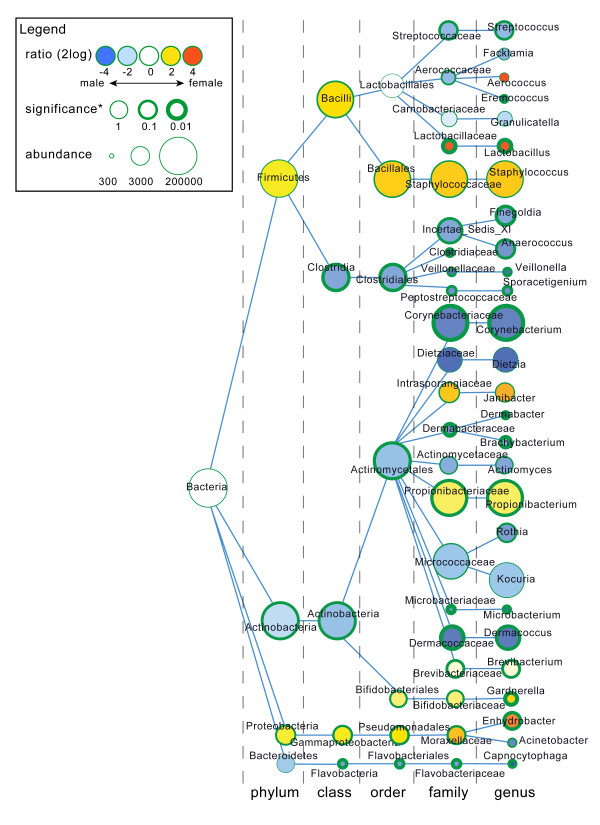
Difference in microbial community composition between males and females. Nodes represent taxa, edges link the different taxonomic levels. The fold increase is calculated as the 2log of the ratio of the relative in males and females (0 = no difference between genders, 1 = twice as abundant in female, and so on). The significance is expressed as the P-value of a Mann-Whitney U test of the male and female samples. Note that the relation between node-size and total abundance is non-linear.